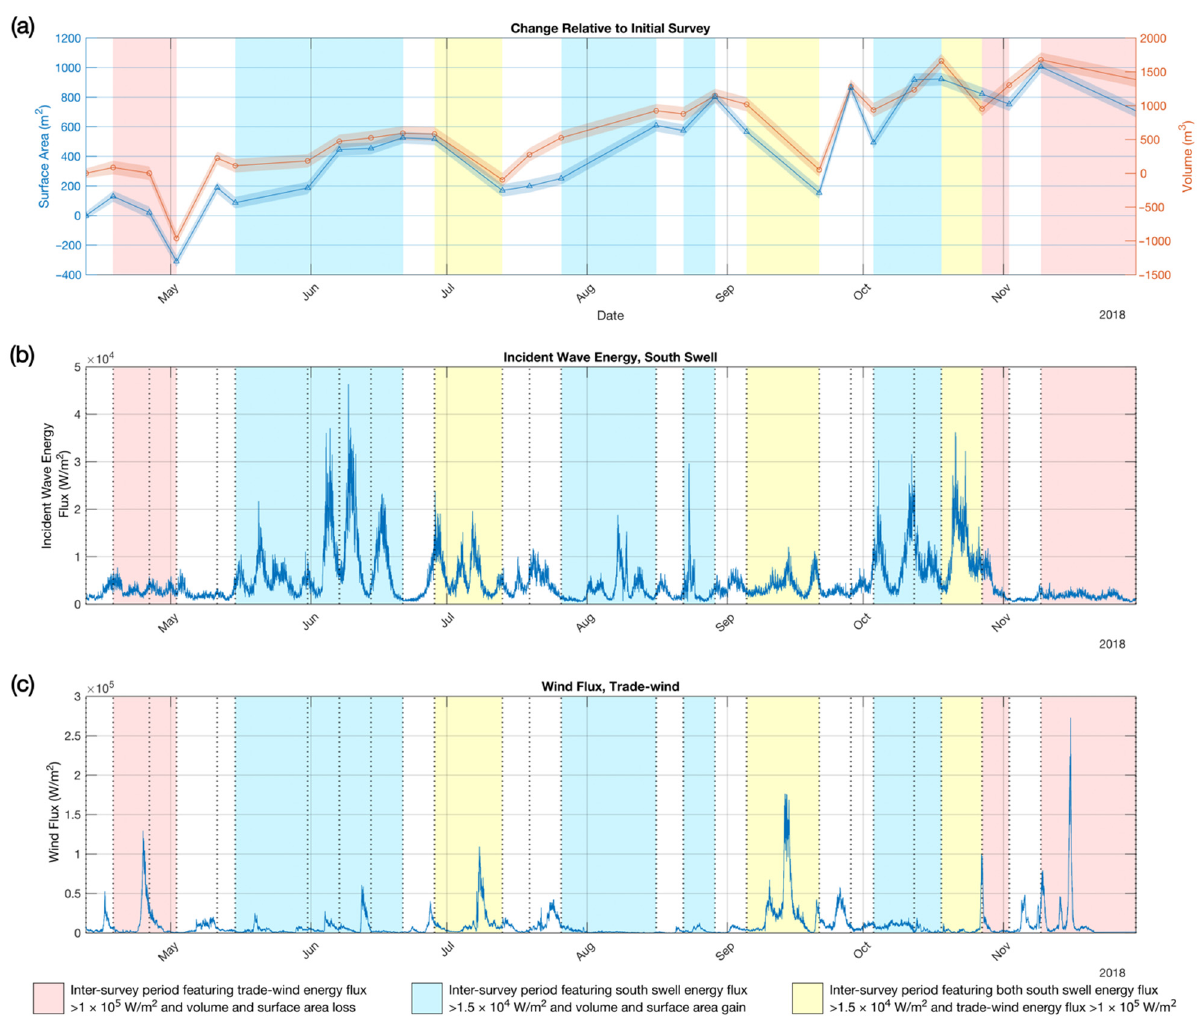
Figure 5. Surface area and volume of the subaerial beach above MHHW ( a ) plotted alongside incident wave energy flux for south swell (( b ); wave periods: 14–30 s; wave direction: 147–220°N) and wind flux for trade winds (( c ); wave periods: 3–10 s; wave direction: 45–160°N). A gradual increase in area and volume throughout the time series: the beach gained 708.5 ± 43.5 m 2 (area) and 1384.8 ± 102.2 m 3 (volume). The overall trend of accretion was interrupted by short-lived erosion events,